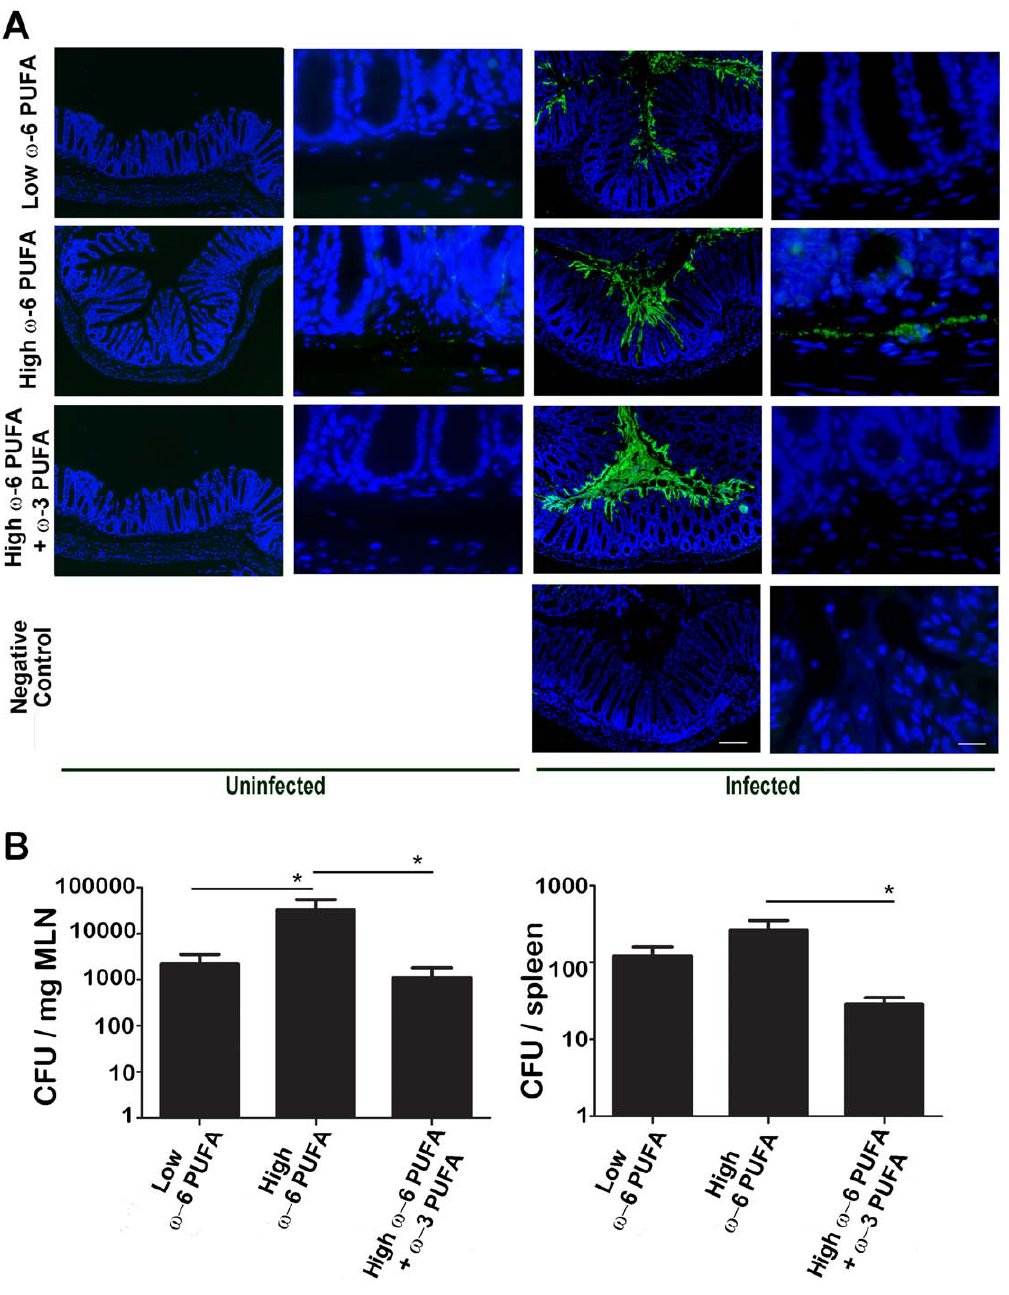
Figure 5. v -6 PUFA rich diets resulted in increased translocation of microbes from Enterobacteriacea across the intestinal mucosae. A) Colonic tissue sections were hybridized with a c -Proteobacteria probe (green) and the nuclei stained with DAPI (blue) to examine the locations of Enterobacteriaceae. These Gram-negative microbes were found in the submucosae (600 6 magnification scale bar=14.2 m m) prior to infection in the colons of mice fed v -6 PUFA rich diets. During infection with C. rodentium , a member of Enterobacteriaceae, the pathogen was found deep into the crypts (100 6 magnification, scale bar=85.4 m m; upper panel) and in the submucosae (600 6 magnification scale bar=14.2 m m) in the colons of mice fed v -6 PUFA rich diets. B) Colony forming units (CFU) recovered from the spleen and mesenteric lymph nodes (MLN) were highest from mice fed v - 6 PUFA rich diets after 10 days of C. rodentium infection. CFU were enumerated from tissues removed from mice fed various diets and were homogenized followed by plating in serial dilutions on Lb agar. (*, P , 0.05). doi:10.1371/journal.pone.0055468.g005 fat-1 mice, reduces COX-2 and PGE2 expression protecting exacerbated colitis when challenged with DSS in adulthood against DSS-colitis [39]. Despite such positive evidence, other [16]. Thus, while the overabundance of dietary v -6 PUFA may studies show that diets rich in v -3 PUFA exacerbate murine colitis cause excessive gut inflammation, the effects of fish oil supple- through impaired expression of intestinal adiponectin [17]. mentation on colitis are unclear. In this study, v -6 PUFA rich Similarly, the offspring of rats fed fish oil perinatally have diets increase intestinal damage and inflammation during in-